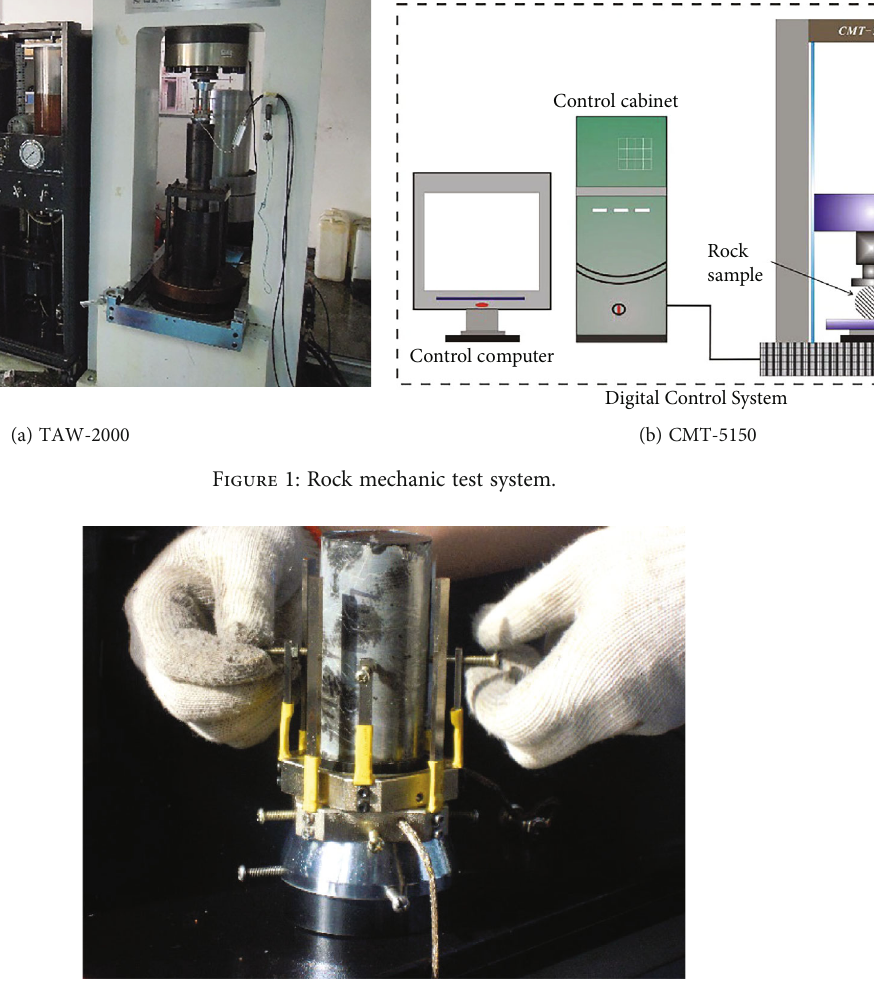
Figure 2: Uniaxial compression test of shale